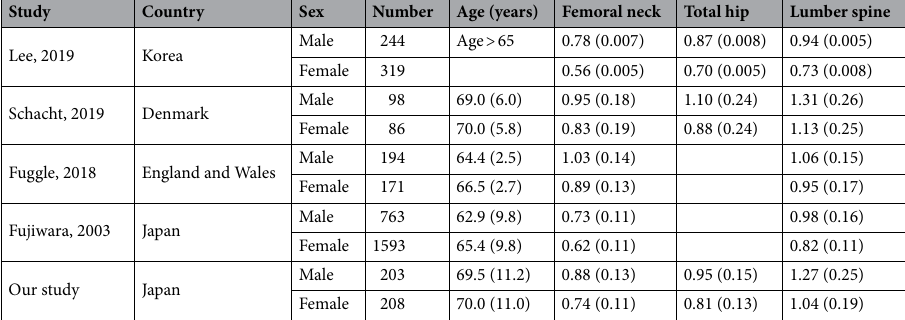
Table 7. Mean BMD values in previous reports. Values represent mean (standard